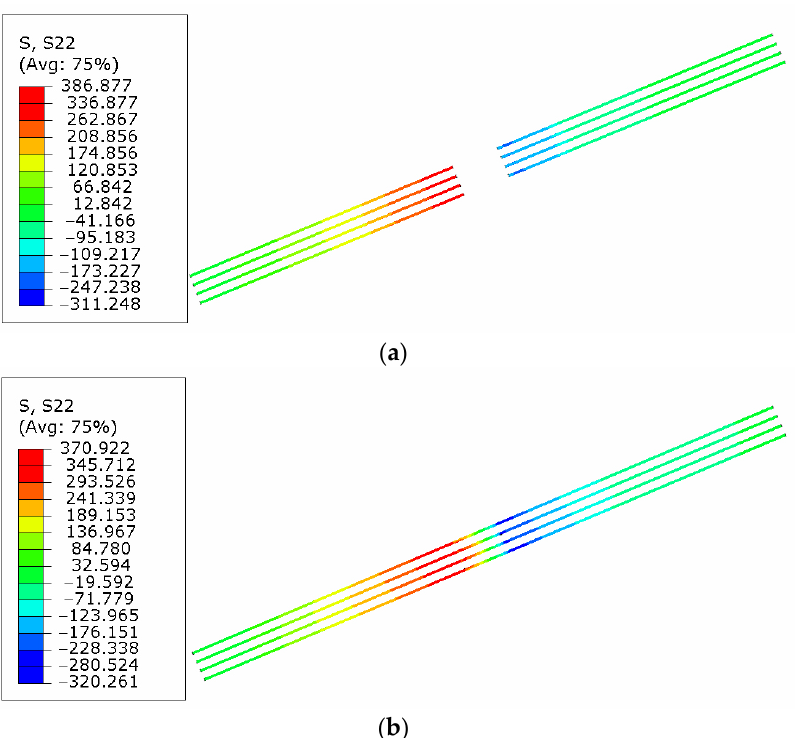
Figure 17. Longitudinal stress distribution of rebars in concrete slab at the yield state: ( a ) RS con- nection; ( b ) RT connection. connection; ( b ) RT connection.